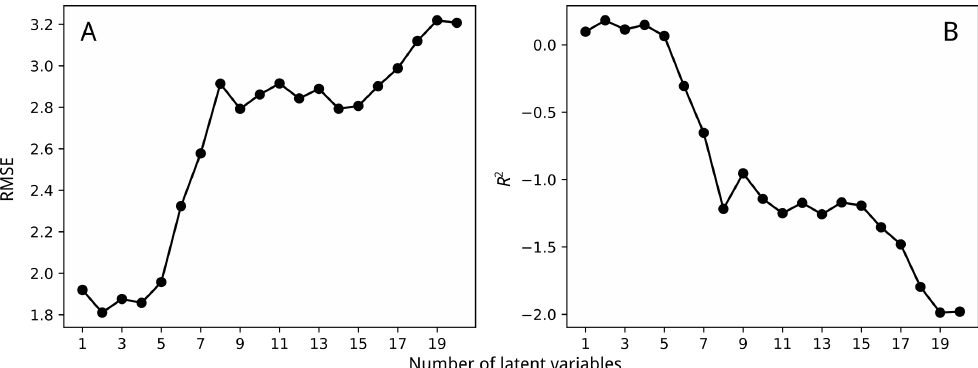
Figure 7. Performance of partial least squares regression (PLSR) in cross-validation with k = 5. ( A ) Root-mean-squared error ( RMSE ), and ( B ) R 2 . These graphs could be used to indicate the consistency of the data for modeling. Both curves indicate that the data is not useful for